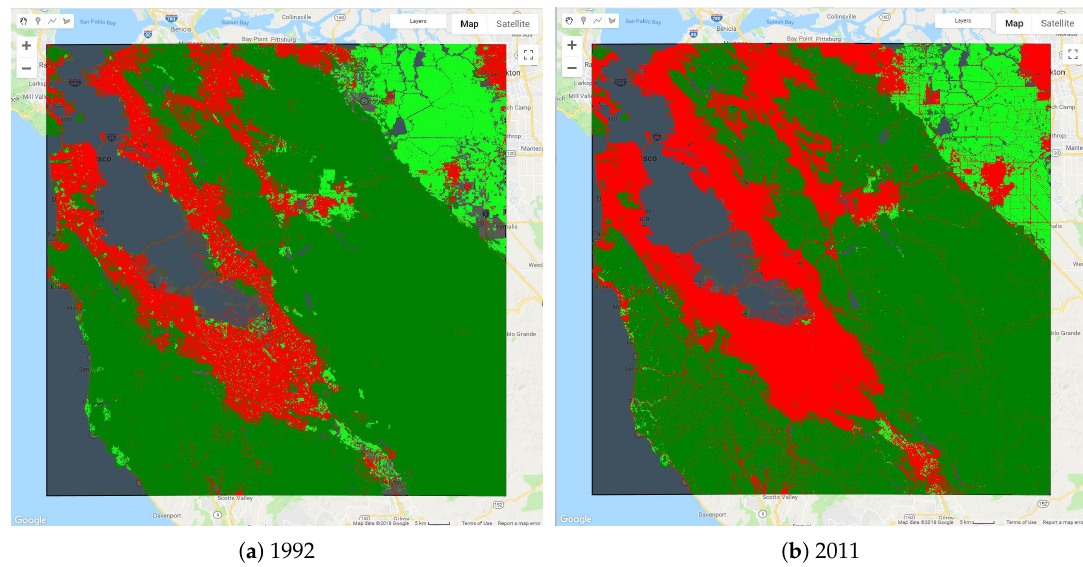
Figure 20. San Francisco MA: LC situation in 1992 ( a ) and in 2011 ( b ). In red, the Urbanized class, in light green, the Cultivated class, in dark green, the Forest and Shrubland classes.